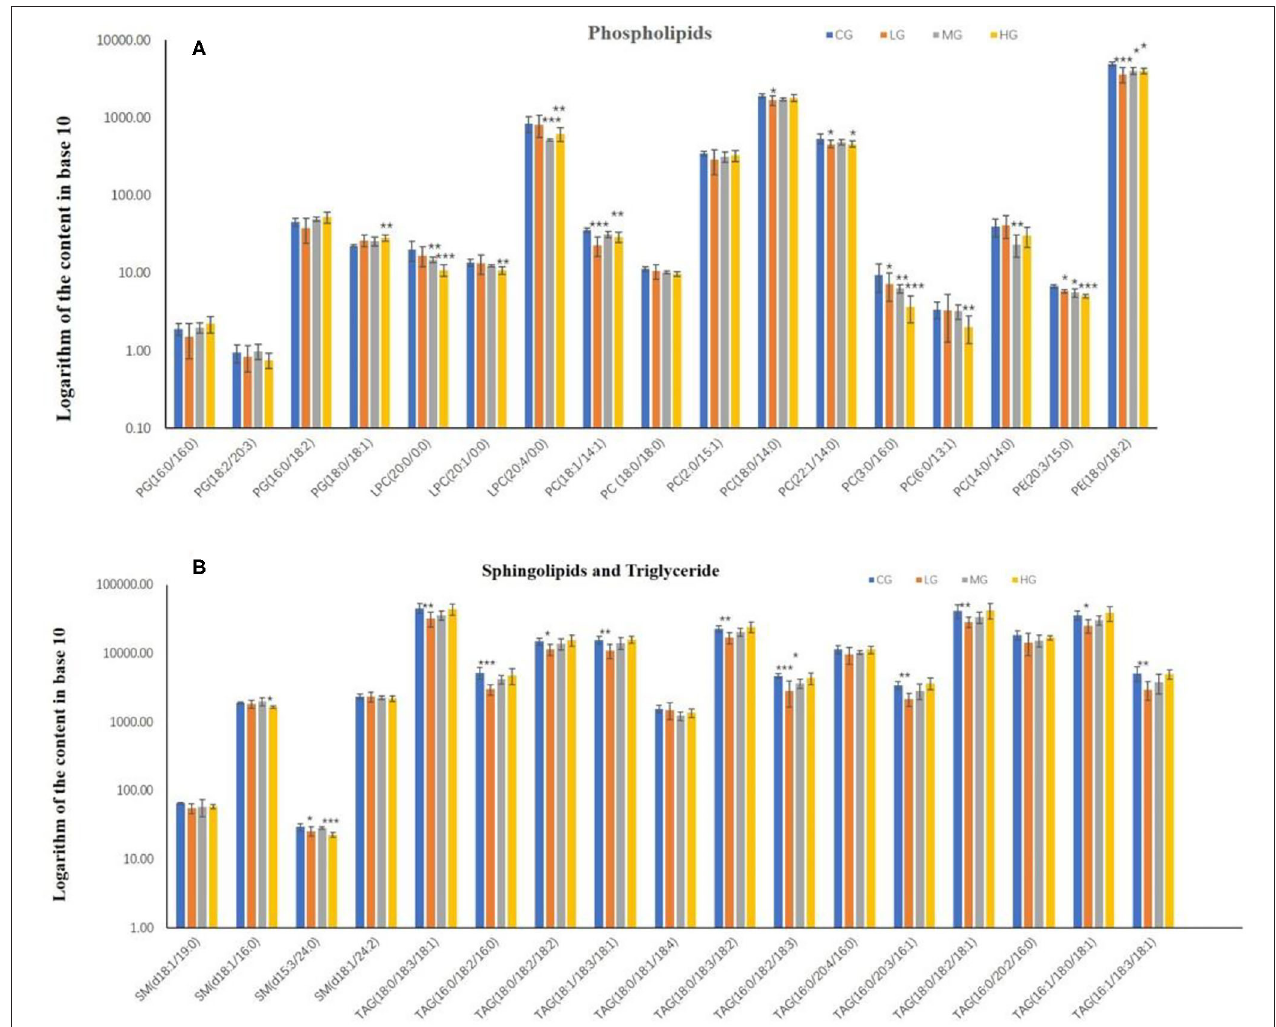
FIGURE 3 | The content of phospholipids (A) and sphingolipids and triglyceride (B) in the liver of mice in high-dose group (HG), middle-dose group (MG), low-dose group (LG) and control group (CG) ( * P < 0.05, ** P < 0.01, *** P < 0.001, compared with the control group, n = 6).